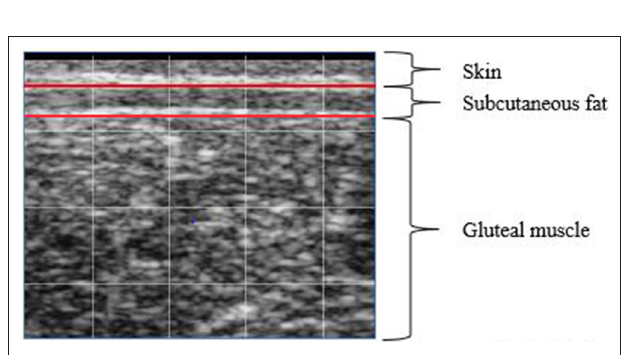
FIGURE 2 | Example of an ultrasound image used to measure subcutaneous fat depth (mm) between the red